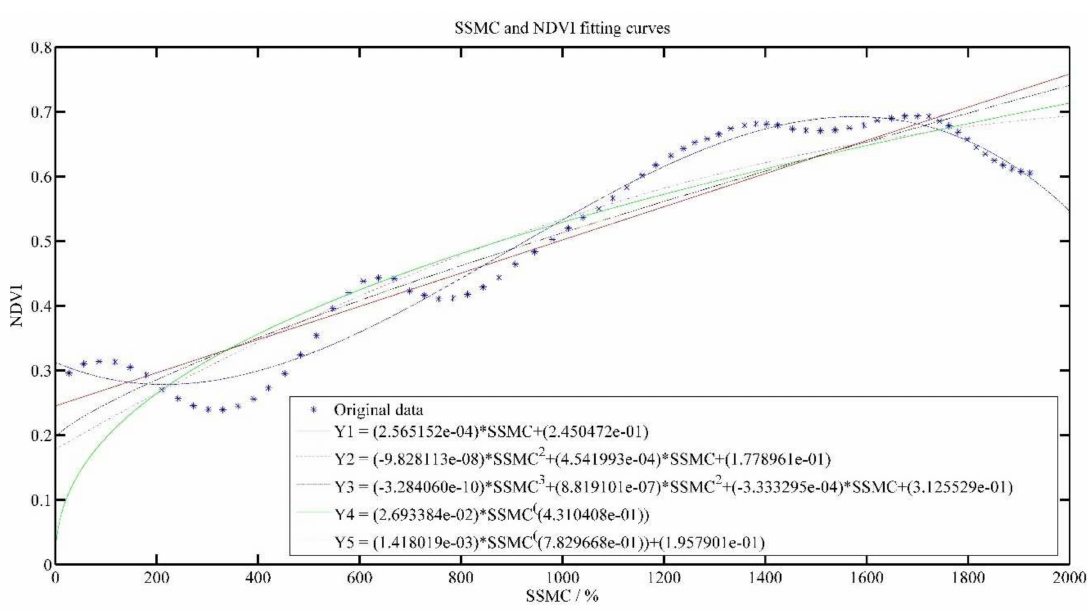
Figure 6. SMC and NDVI model results.